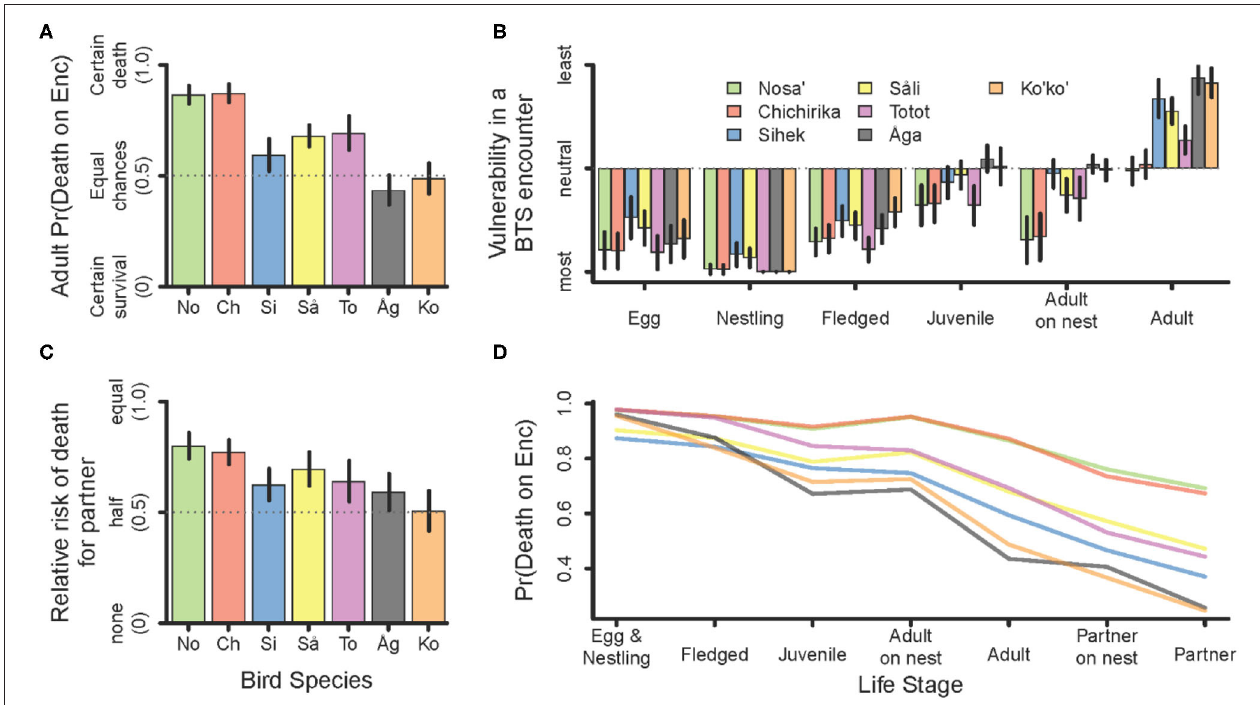
FIGURE 2 | Components determining risk of death in an encounter with a BTS. (A) Ranking (probability) of death for an initially encountered adult. (B) Relative vulnerability ranking among bird life stages. (C) Relative risk ranking (probability) of death for the partner of a bird initially encountered. Error bars delineate the 95% CI. (D) Composite measure of the bird-stage-specific probability of death for a bird encountered by a BTS. Birds in (A) through (C) are listed along the x-axis in order of increasing size (No = Nosa ' , Ch = Chichirika, Si = Sihek, Så = Såli, To = Totot, Åg = Åga, Ko = Ko ' ko '